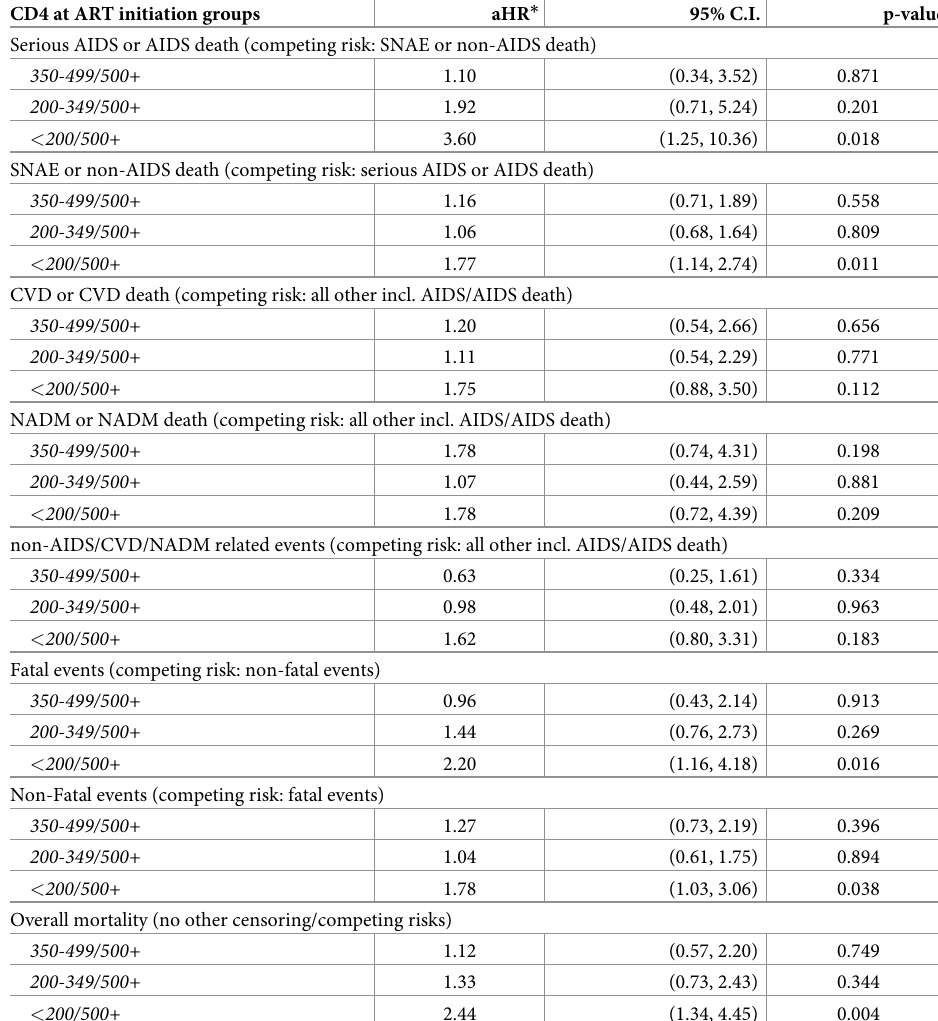
Table 4. Results from multivariable Fine and Gray models (when competing risk is present) and Cox proportional hazards model (for overall mortality). CD4 at ART initiation groups